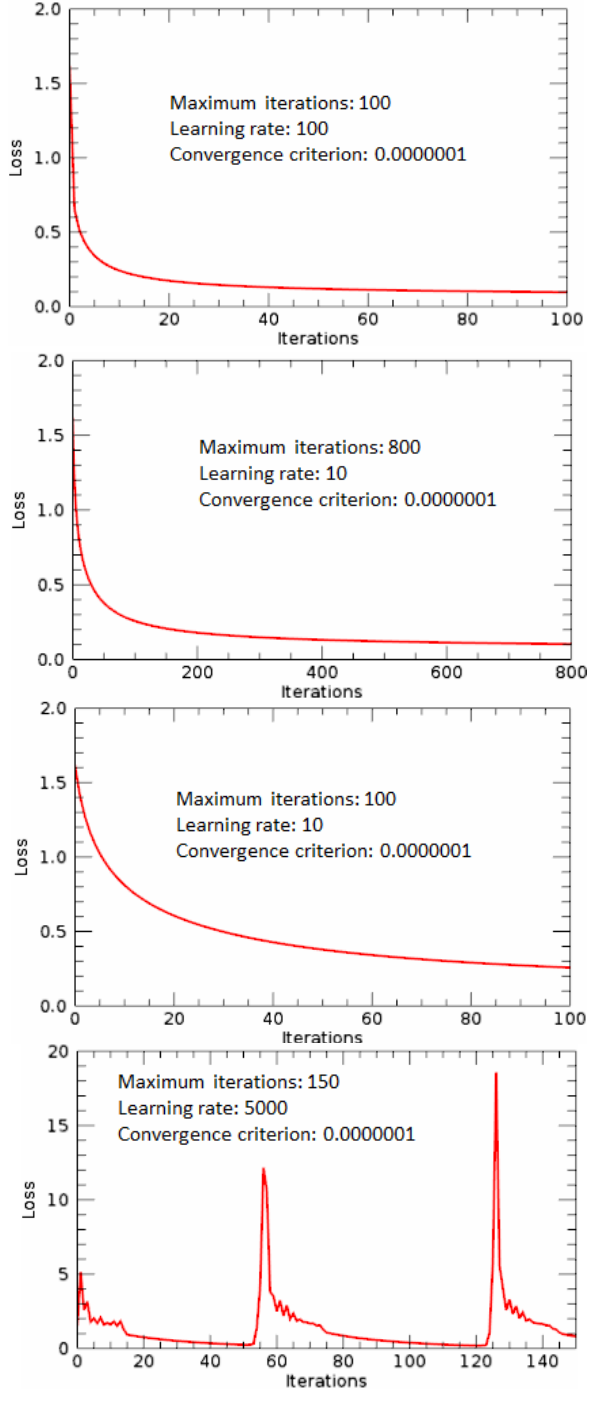
Figure 6. Loss profiles are used for the evaluation of the Softmax Regression classifier. A) The curve should flatten and approach a minimum value. B) If the learning rate is set to a smaller value, the maximum number of iterations must be increased for the loss function to converge. This can increase processing time. C) If the learning rate is set to a smaller value without increasing the maximum number of iterations, the curve starts to approach a minimum but never reaches it. D) If the learning rate is set too high, the loss profile reveals oscillations and the solution never